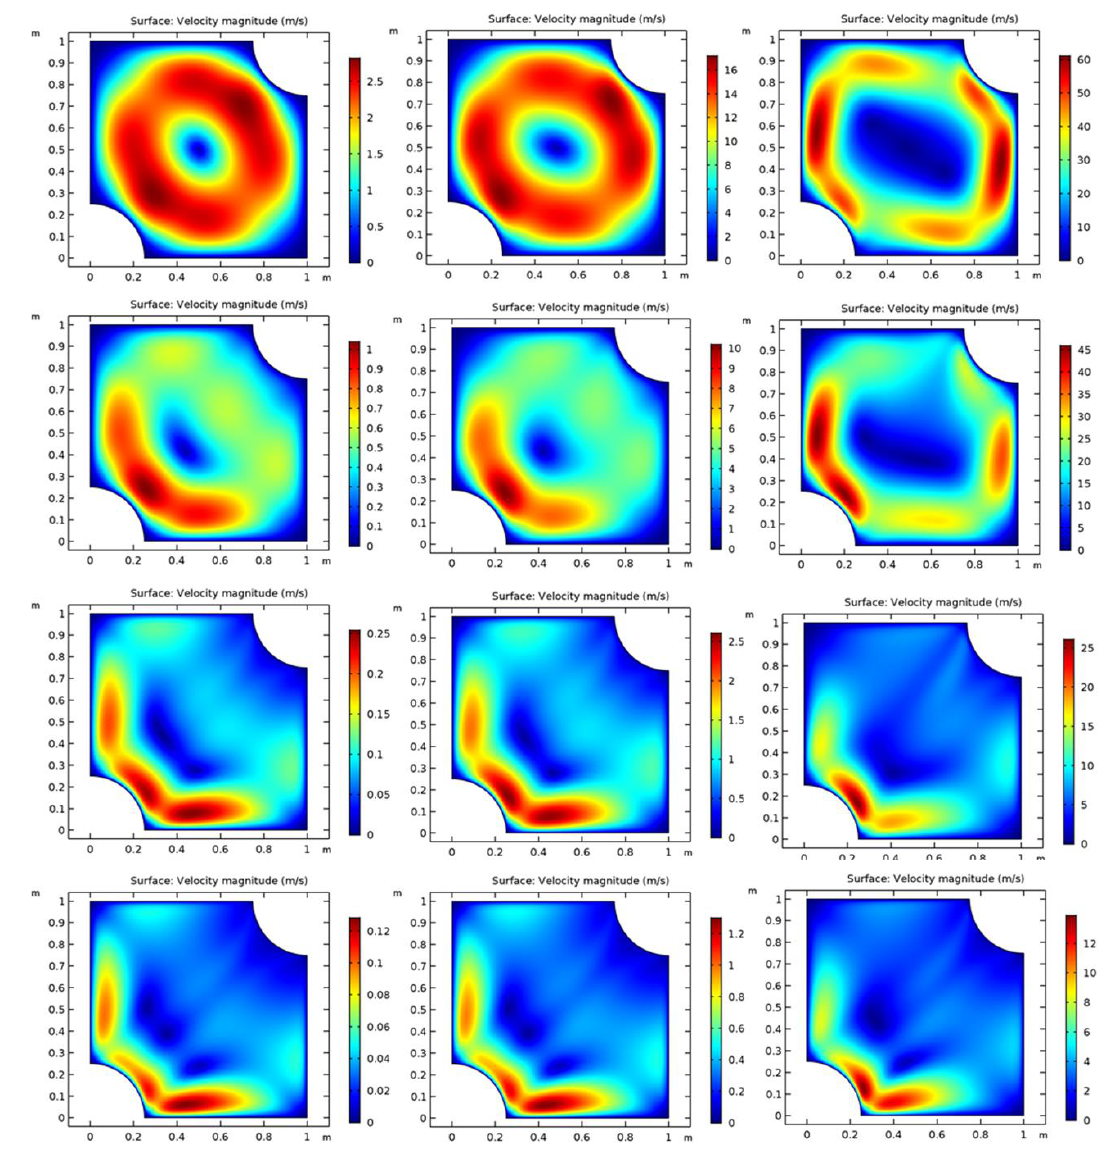
Figure 6. Effect of Hartmann number and Rayleigh number on the surface velocity magnitude